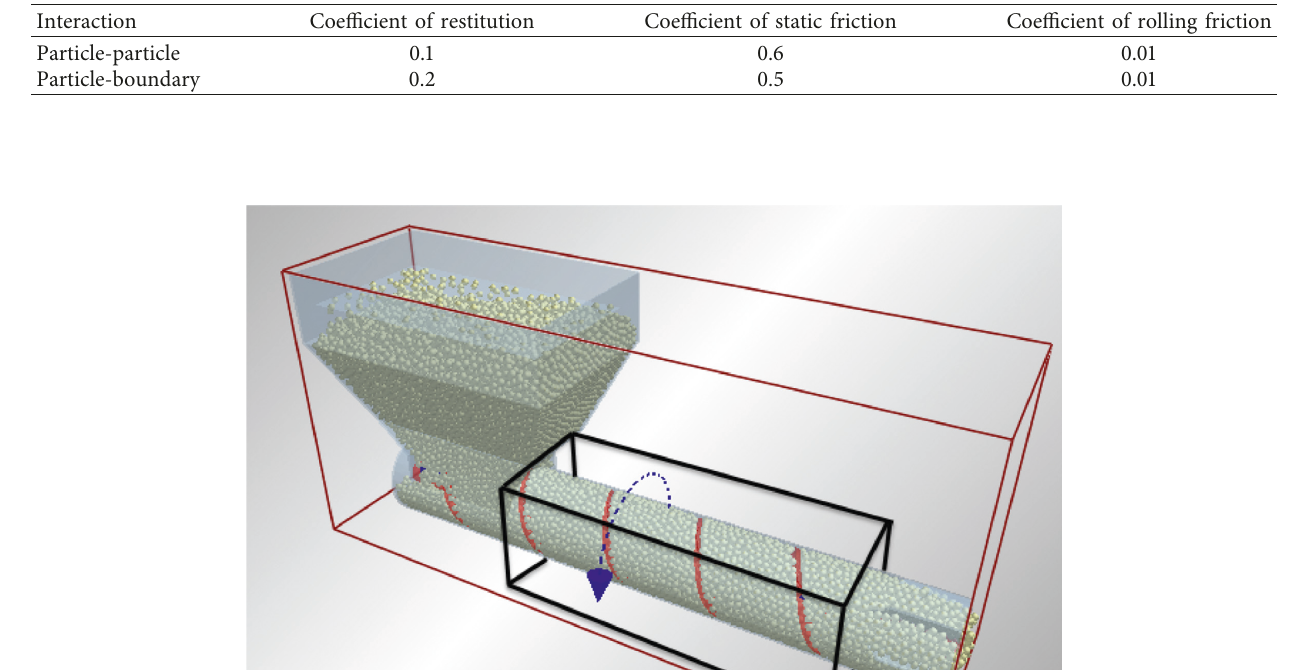
Table 2: Contact parameters used in the simulation.